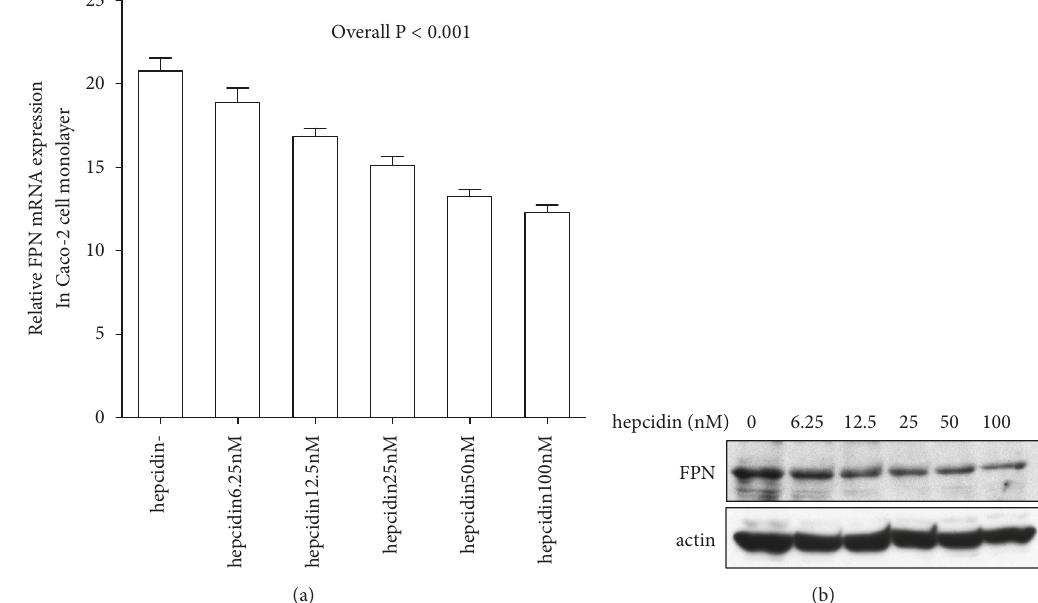
Figure 5: FPN expression in Caco-2/TC7 cell monolayers. FPN mRNA expression levels in Caco-2/TC7 cell monolayers cultured with or without hepcidin were measured by Taqman real-time PCR (a). FPN mRNA levels in Caco-2/TC7 cell monolayers were downregulated dependent on hepcidin concentration (P < 0.0001; Jonckheere–Terpstra test). FPN protein expression was analyzed by western blot (b). FPN protein in Caco-2/TC7 cell monolayers was downregulated dependently on hepcidin concentration.